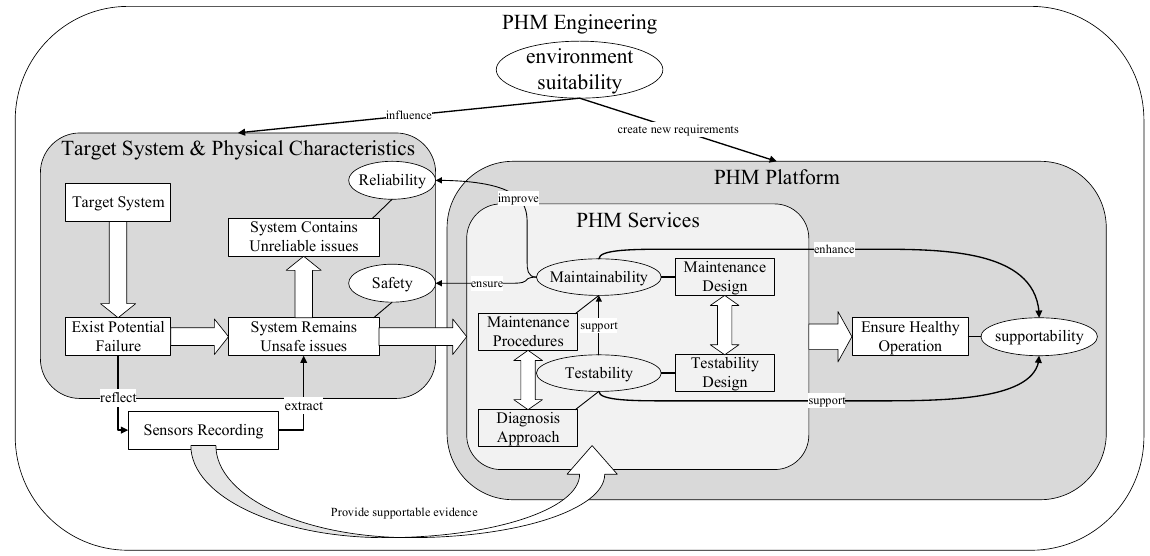
Figure 1. Element and the corresponding relationship of PHM engineering.